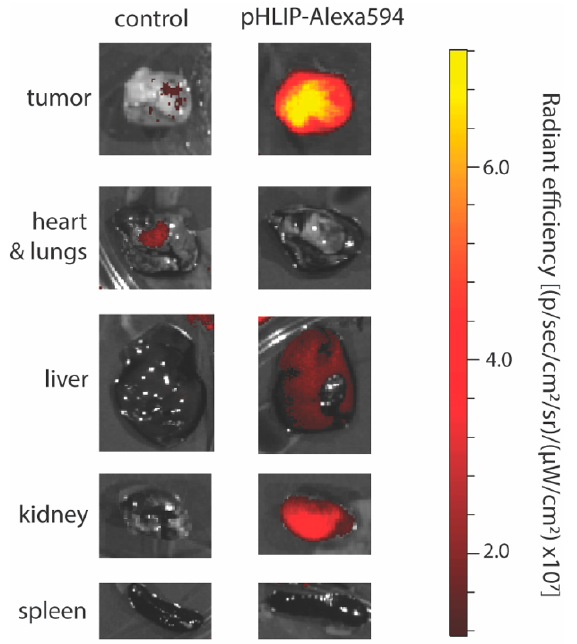
Figure 2. Selective targeting of the tumor microenvironment with pHLIP. Fluorescence in isolated HeLa tumors and selected organs from mice 24 h after systemic (intravenous) administration of vehicle (control) or pHLIP-Alexa594 (2 mg/kg).